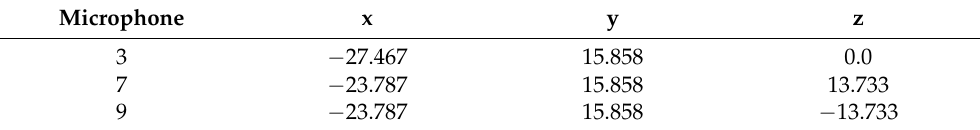
Table 1. Locations of microphones 3, 7, and 9 in the experiment (normalized by the chord length).